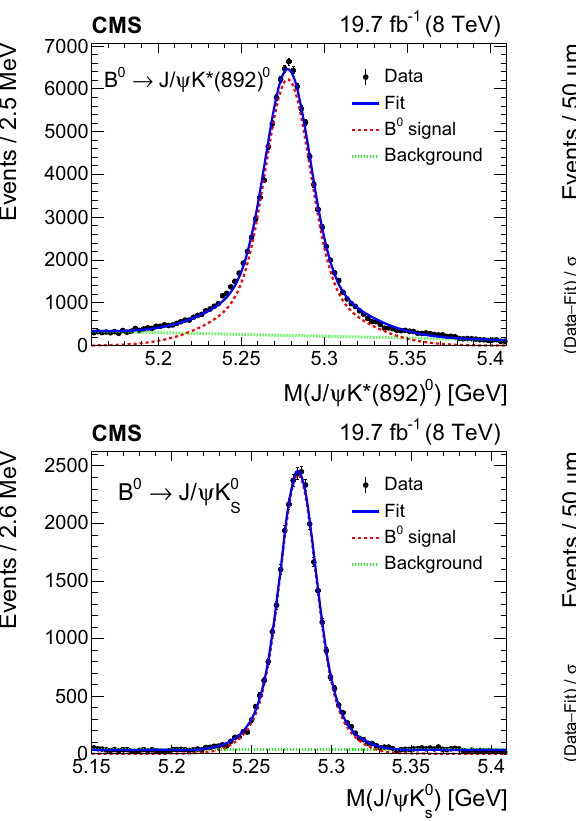
signal and background (solid) shown. the lower panels of the figures on the right show the difference between the observed data and the fit (lower) S divided by the data uncertainty. The vertical bars on the data points represent the statistical uncertainties